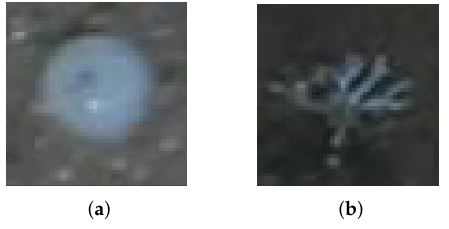
Figure 4. Γ CCZ dataset. ( a ) Sponge; ( b ) Coral.